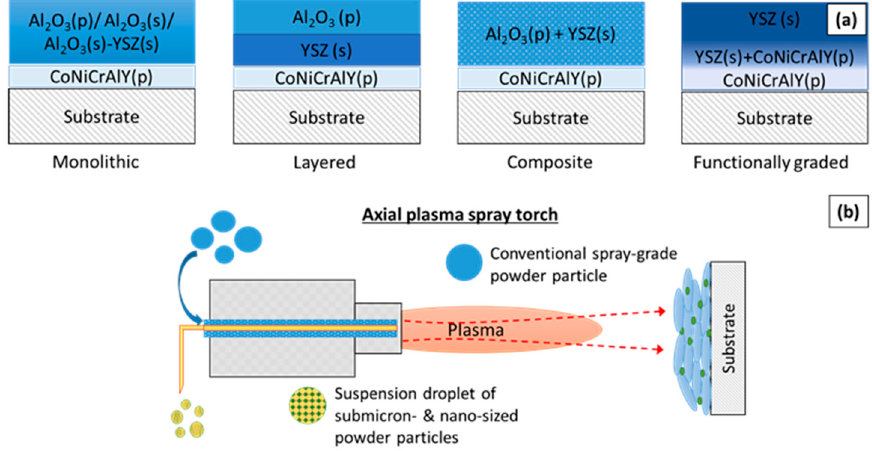
Figure 10. ( a ) Illustration of different coating architectures generated using the hybrid plasma spray setup involving feeding of conventional spray-grade powder (p) and suspension (s) feedstocks as schematically shown in ( b ) [47].